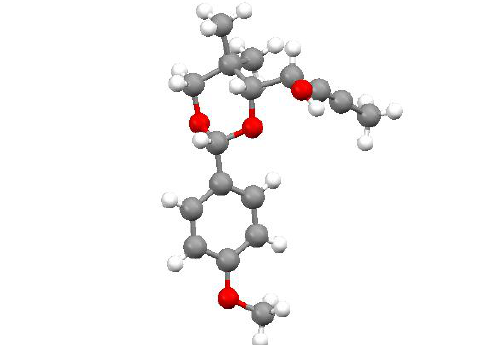
Figure 3. Ball-and-stick representation of propargyl alcohol 1 from X-ray analysis.